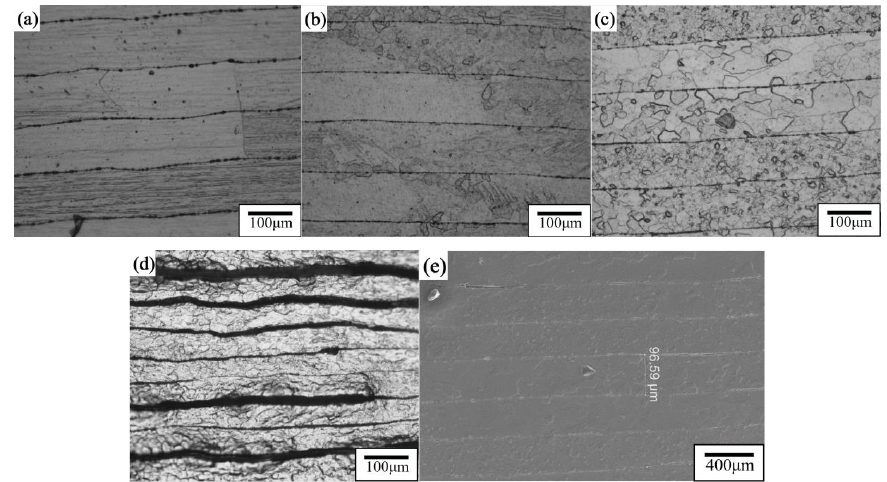
Figure 6. The lateral layered metallographic image and electron microscope image of CNTs/Mg composite material: ( a ) 600 °C sintering; ( b ) 600 °C sintering without preserving pressure after the end of holding time; ( c ) 590 °C sintering; ( d ) 590 °C sintering after the pass 40% hot rolling; ( e ) SEM of the 590 °C sintered sample picture.